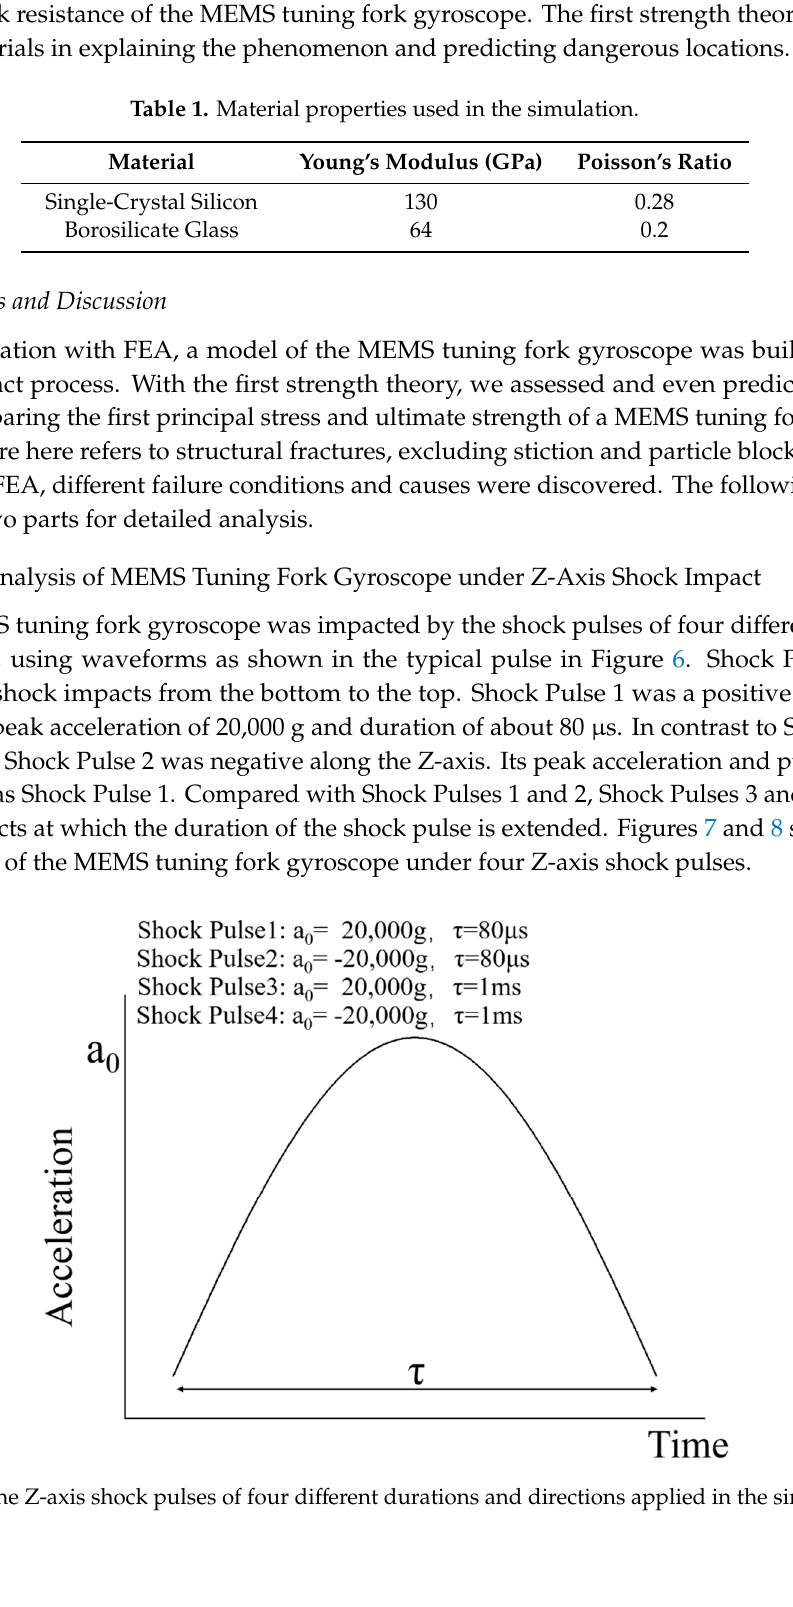
Figure 7. First principal stress of the MEMS tuning fork gyroscope under two Z-axis shock pulses with shock pulse duration of 80 µs.